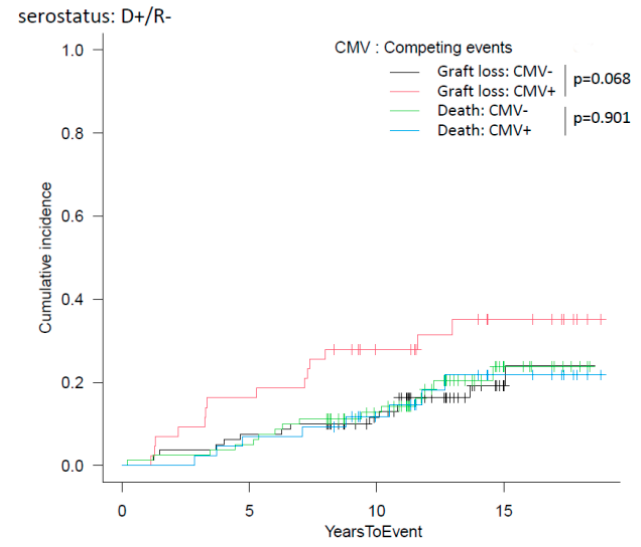
Figure 4. Cumulative incidence of graft loss, accounting for death as a competing risk, in patients with/without CMV replication/disease in the first year after transplantation stratified for donor and recipient CMV serostatus.